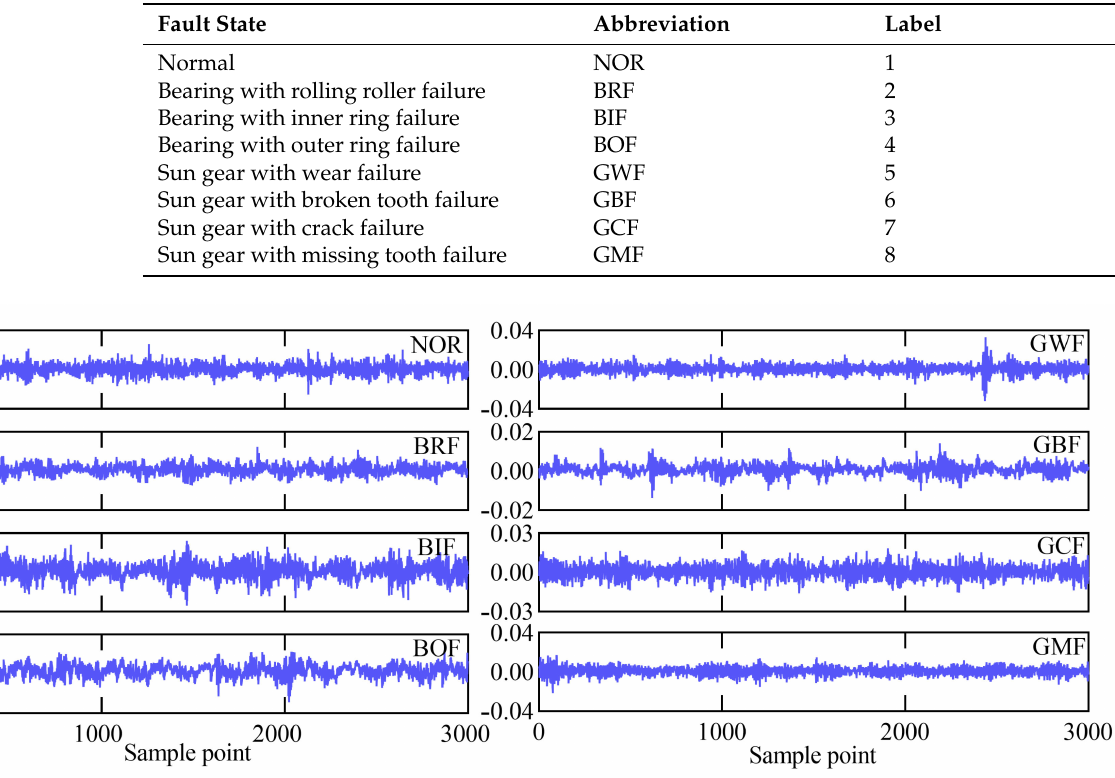
Figure 10. Vibration signals of planetary